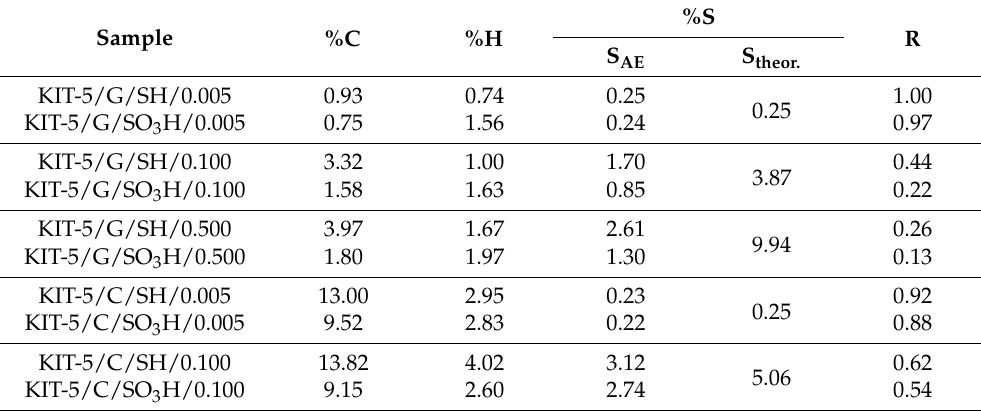
Table 3. Results of elemental analysis for KIT-5 materials modified with thiol or sulfonic groups by grafting or